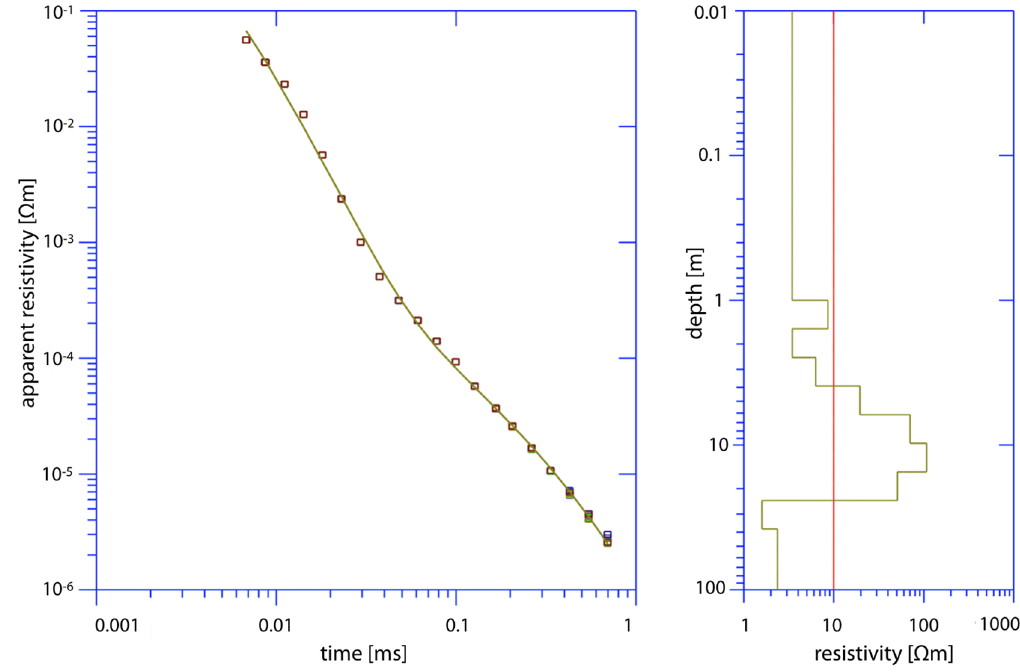
Figure 4. Example of G-TEM data shown as square symbols and the computed resistivity depth profile displayed as a curve passing through all data points with root mean square (RMS) misfit 6.8% ( left ); the fitted model is marked as the dark green line while the red line is the starting model ( right ).